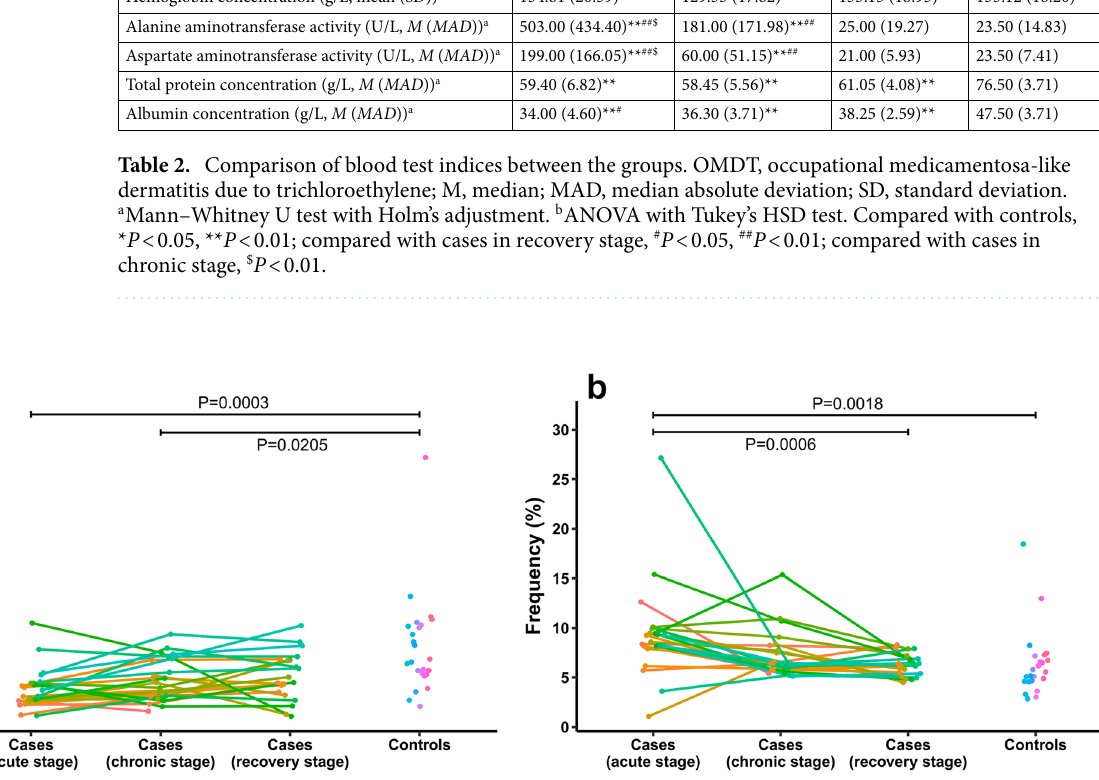
Figure 1. TRBV frequencies of the OMDT cases in acute, chronic, and recovery stages and of the controls. ( a ) TRBV6-4. ( b ) TRBV7-9. Dots of the same color represent TRBV frequencies of the same subject, the connecting lines indicate varying trends, and P values were obtained by the Man-Whitney U test with Holm’s